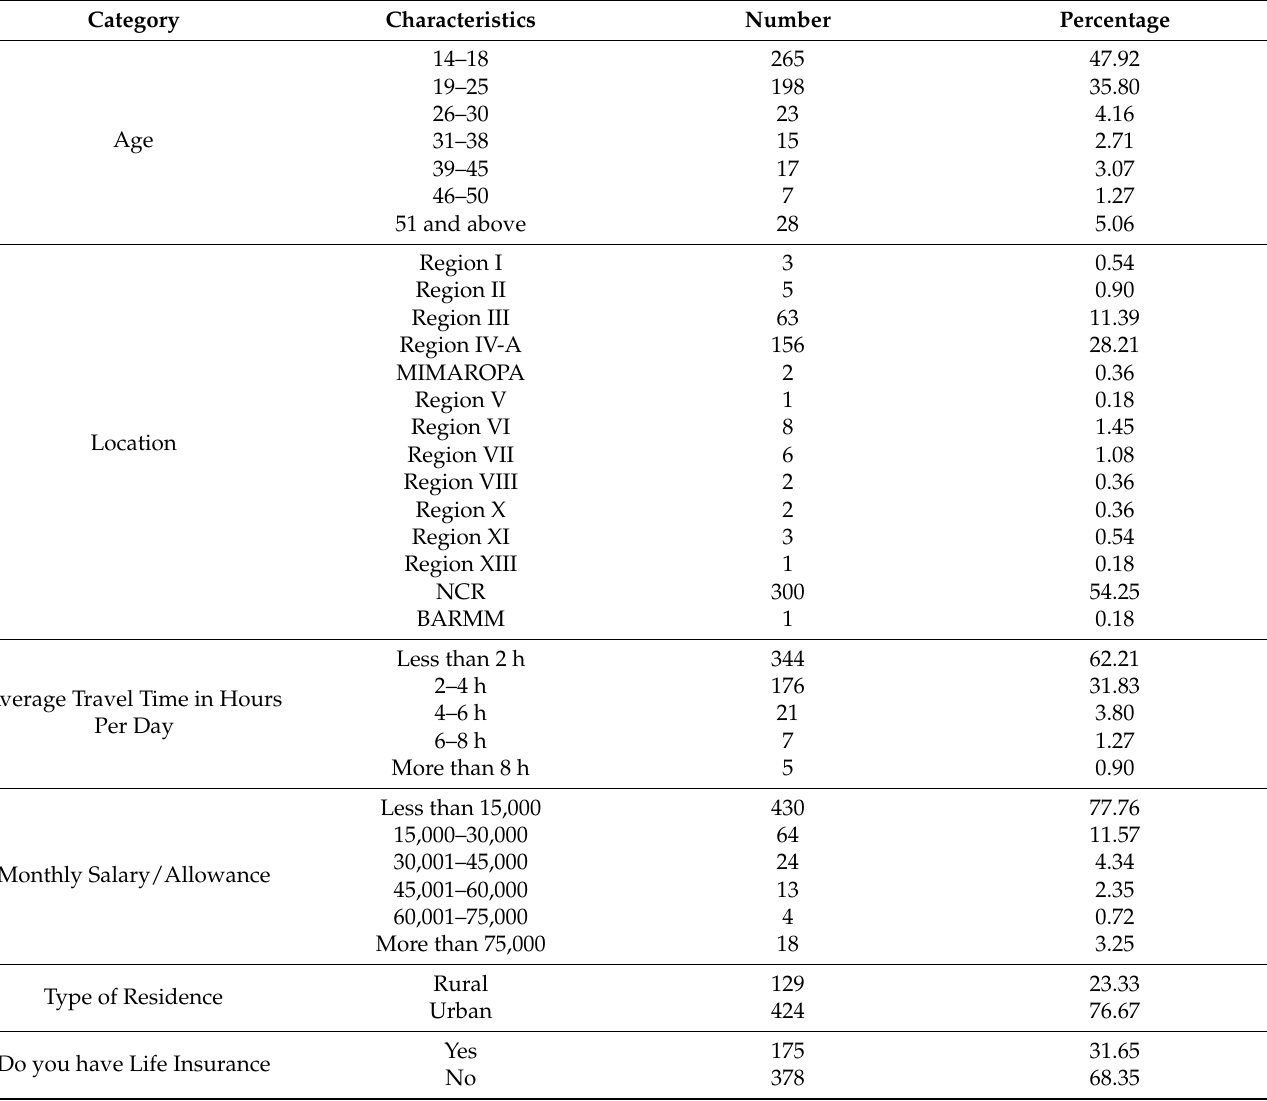
Table 2. Respondent demographics ( n =